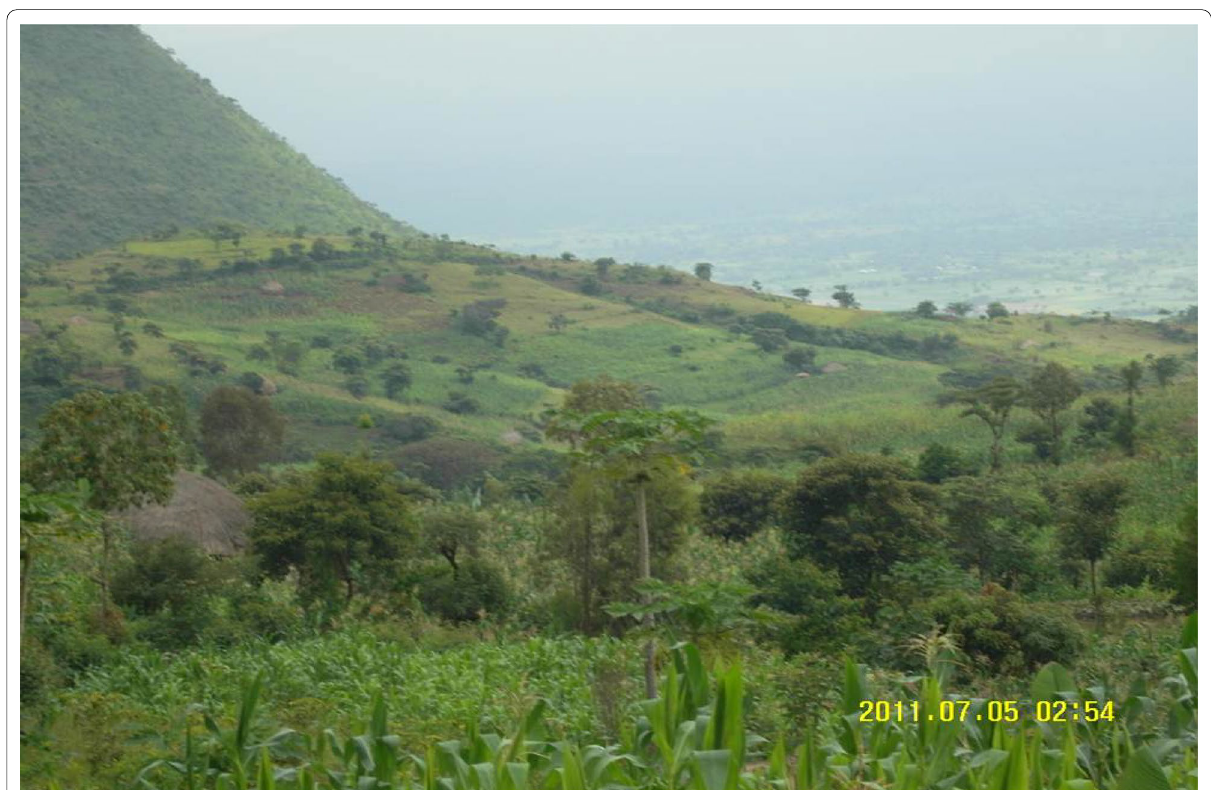
Fig. 1 OFATR as a conservation strategy by households in Deramalo district